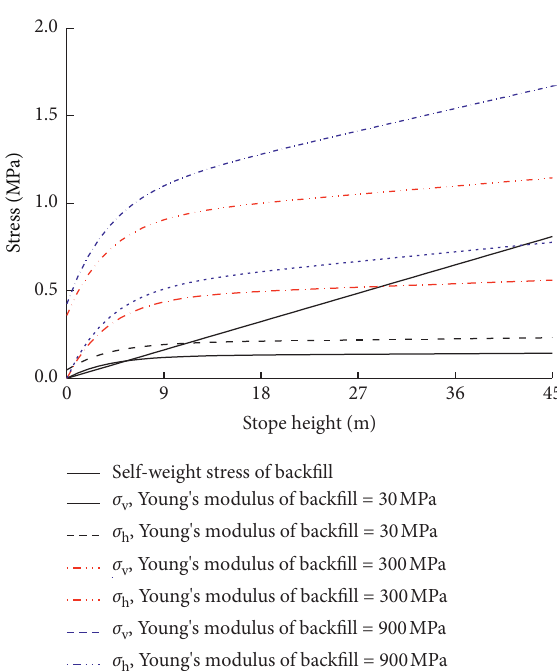
Figure 14: Stope depth effect on time-dependent stress profile of backfilling.